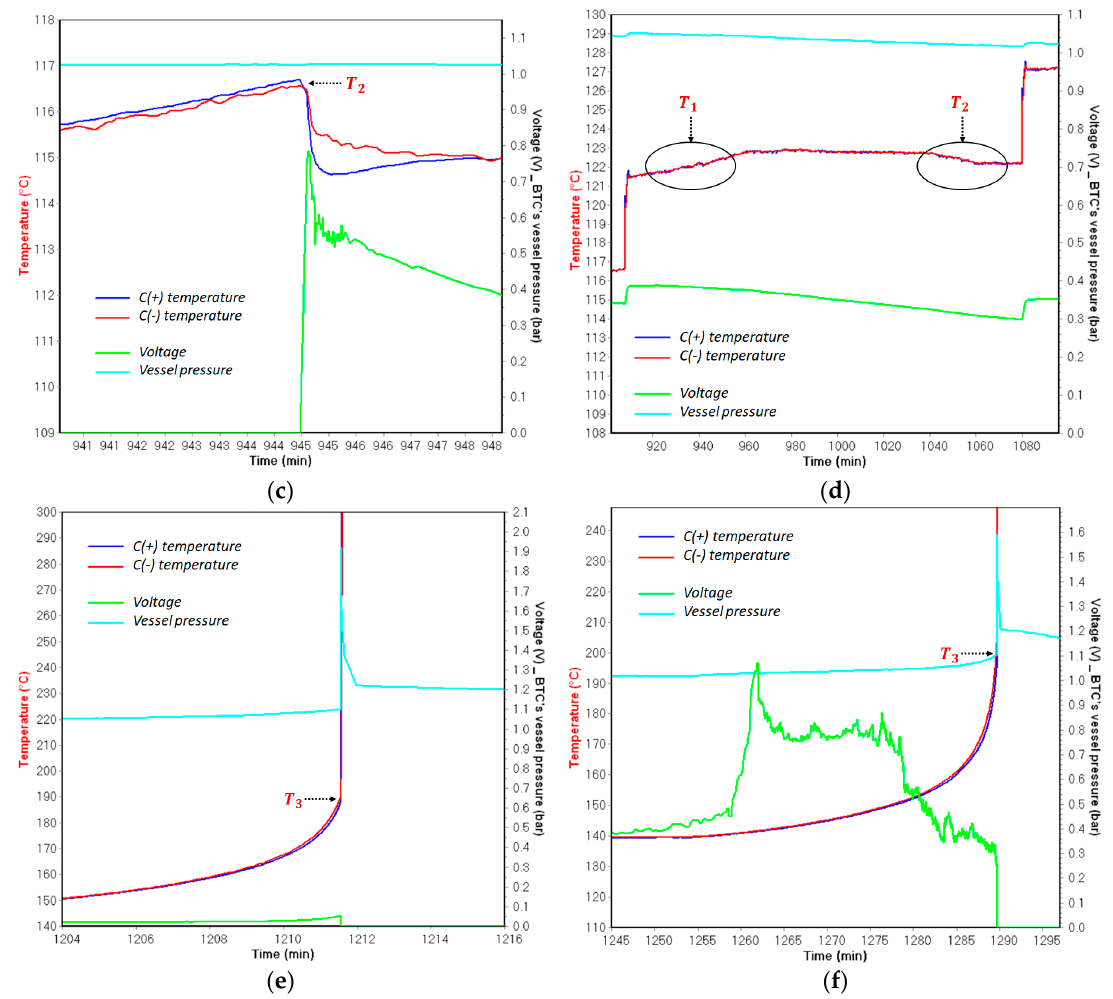
Figure 8. ( a , b ) The 5 stages in the evolution of cell temperatures obtained from the heat–wait–search (HWS) test of LG HG2 at 100% SOC and of Panasonic NCR GA at 100% SOC, respectively; ( c , d ) the initial observations of the endothermic reaction of separator melting of the LG HG2 at 100% SOC and Panasonic NCR GA at 100% SOC, respectively; ( e , f ) the final venting and hard ISC after the ceramic separator layer collapse occurs at T 3 for both the LG HG2 at 100% SOC and Panasonic NCR GA at 100% SOC.